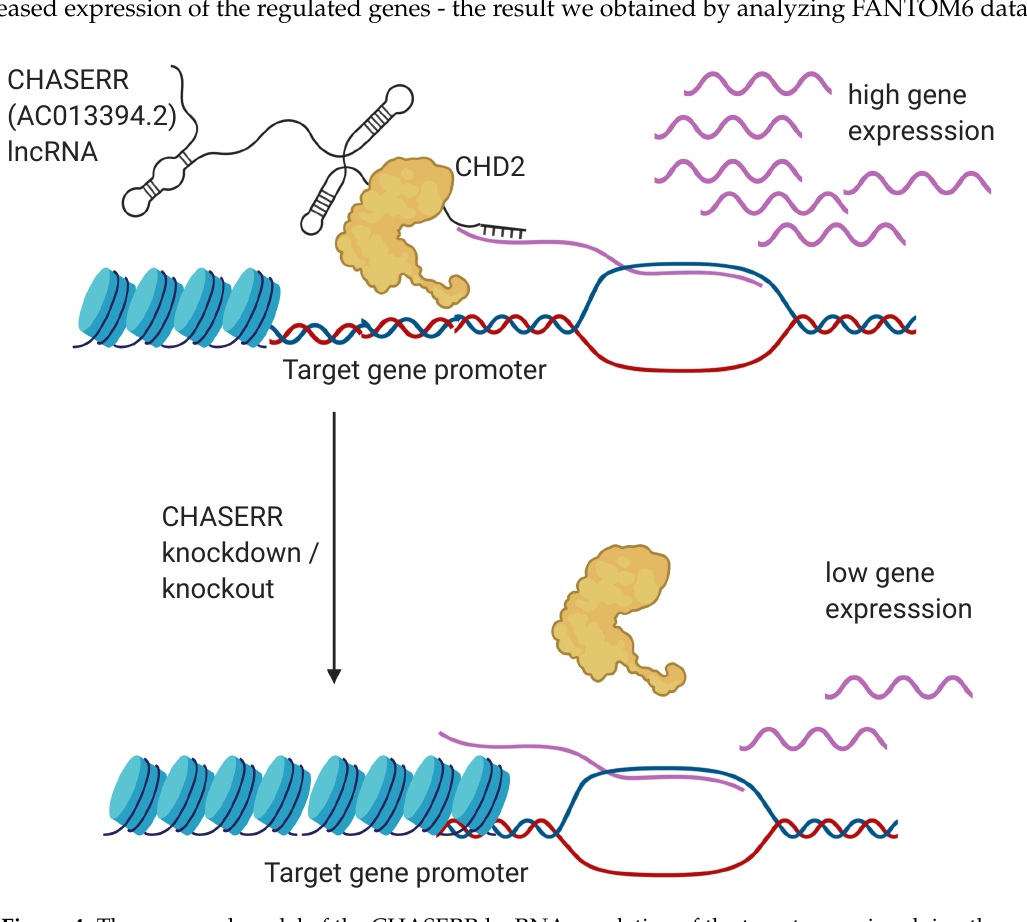
Figure 4. The proposed model of the CHASERR lncRNA regulation of the target genes involving the CHD2 protein and the RNA-RNA interactions with the nascent transcripts. The figure was created with BioRender.com online